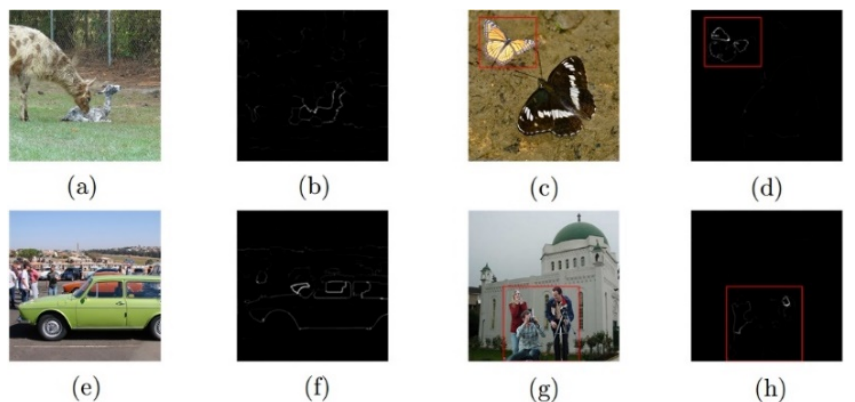
Figure 7. Examples of the CCW-based chroma detection results, where ( a – d ) are the images with correct classification, and ( e – h ) are the images with failed classification. ( a , e ) Untampered images; ( b , f ) chroma detection results of untampered images using CCW; ( c , g ) tampered images; ( d , h ) chroma detection results of tampered images using CCW.